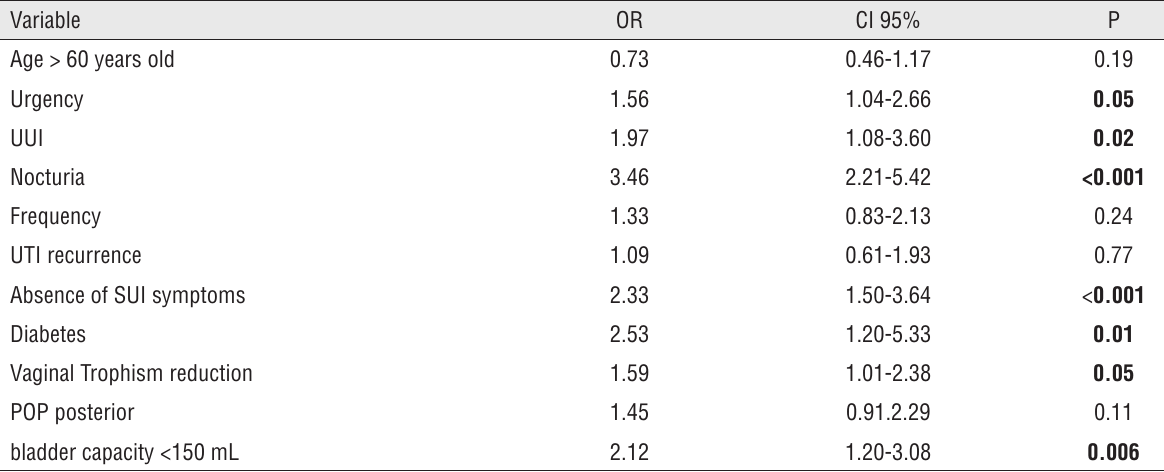
Table 2 - Multivariate analysis of OAD clinical predictors.